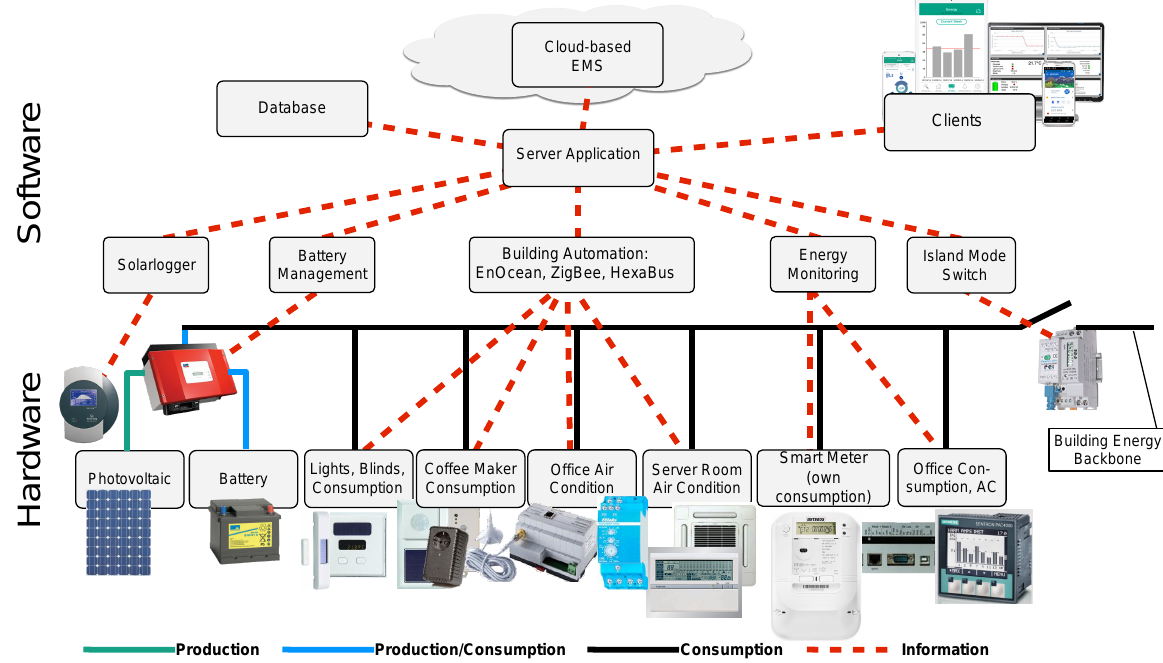
Figure 1. Overview of the Smart Energy Living